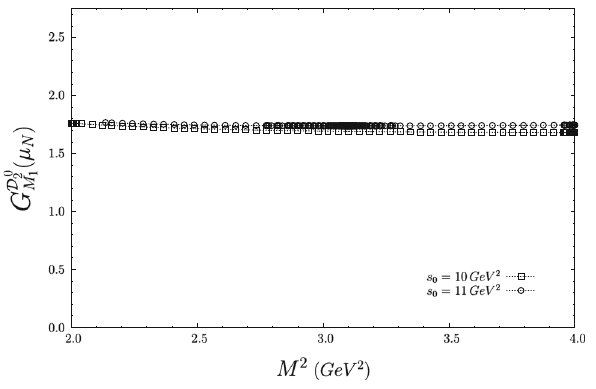
Fig. 2 The same as Fig. 1, but for the negative parity D 0